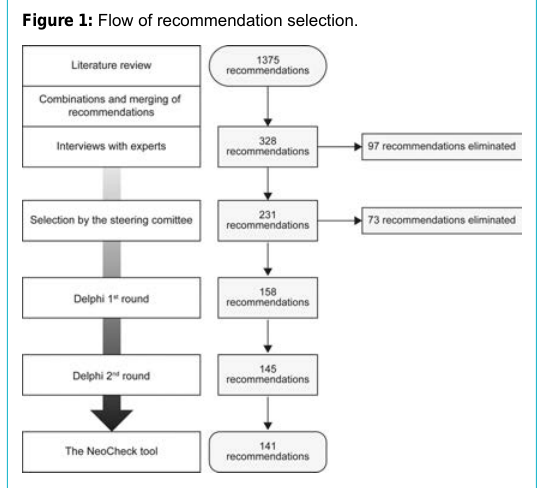
Figure 1: Flow of recommendation selection.